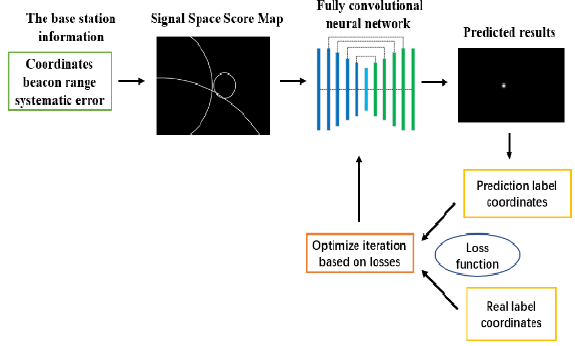
Figure 1 . Overall flow